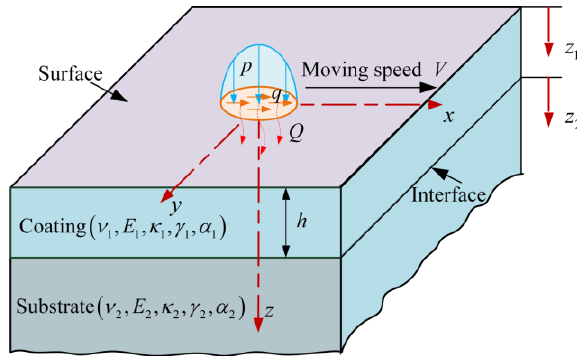
Figure 3. Half space coated with a homogeneous coating subjected to the coupled action of the mechanical loading and the frictional heat flux.